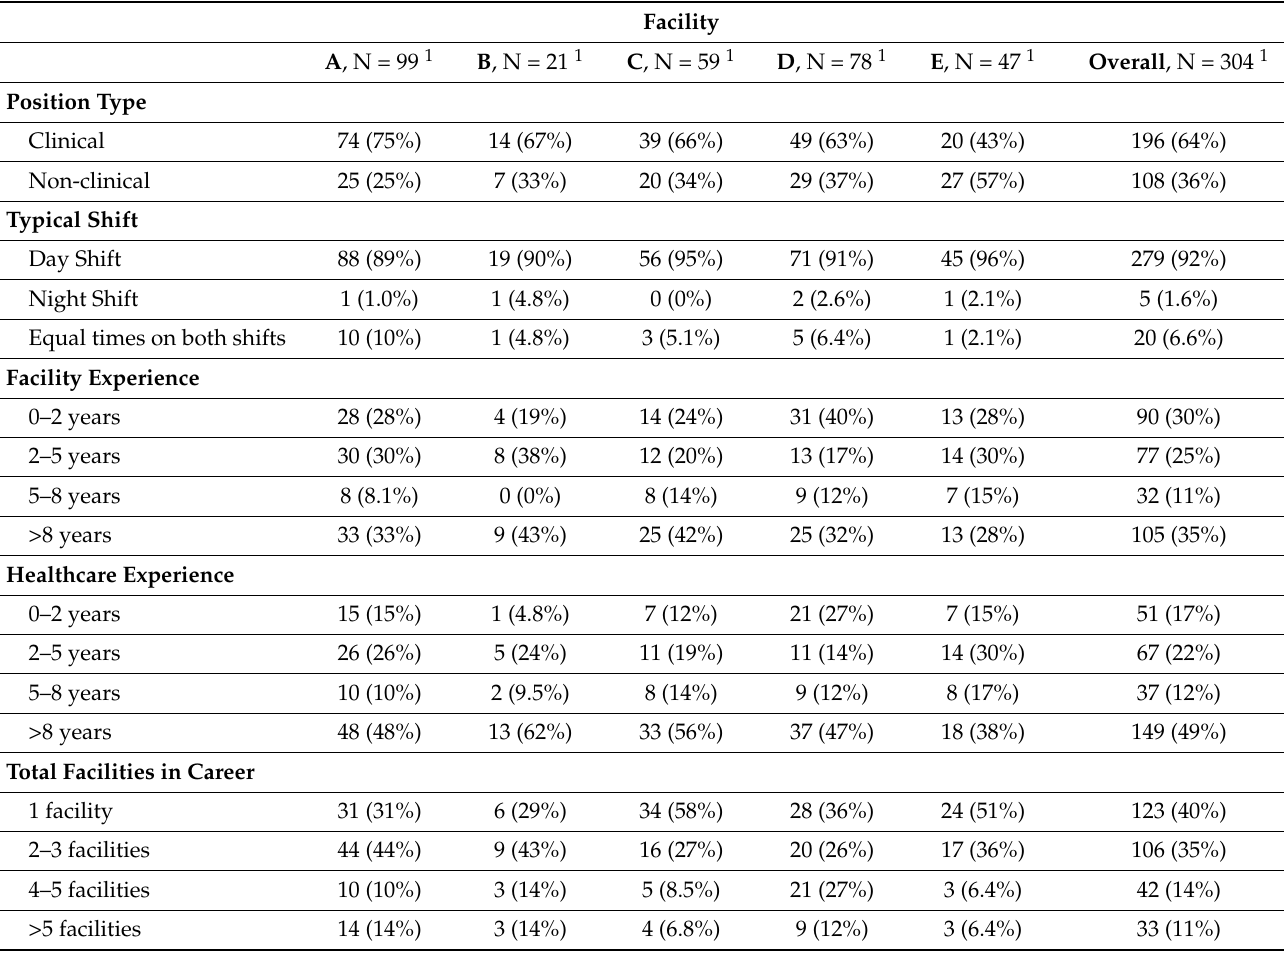
Table 1. Survey participant demographic